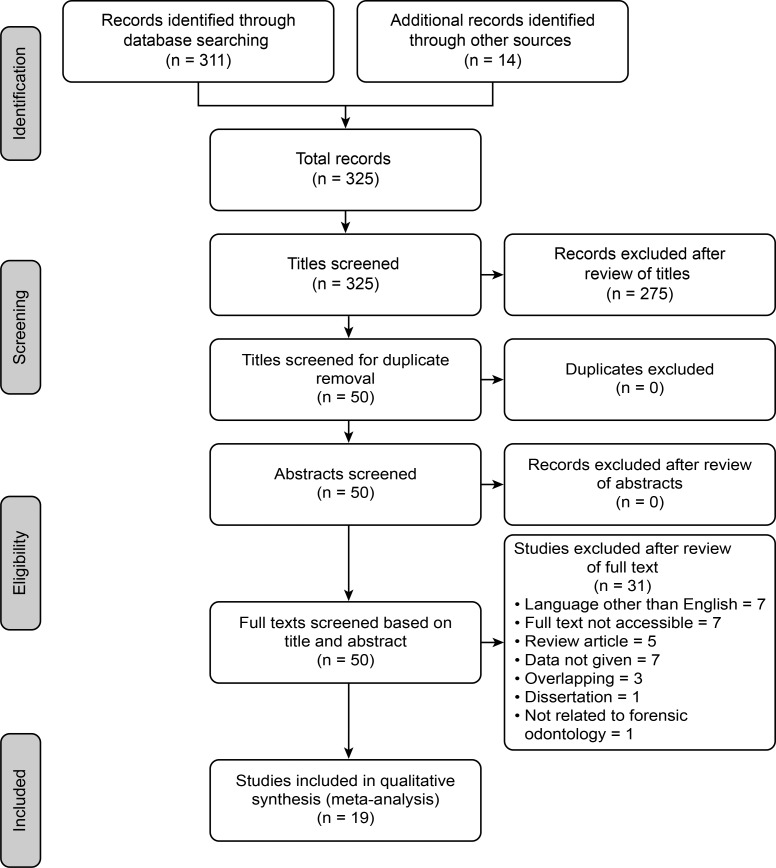
PRISMA flow diagram.